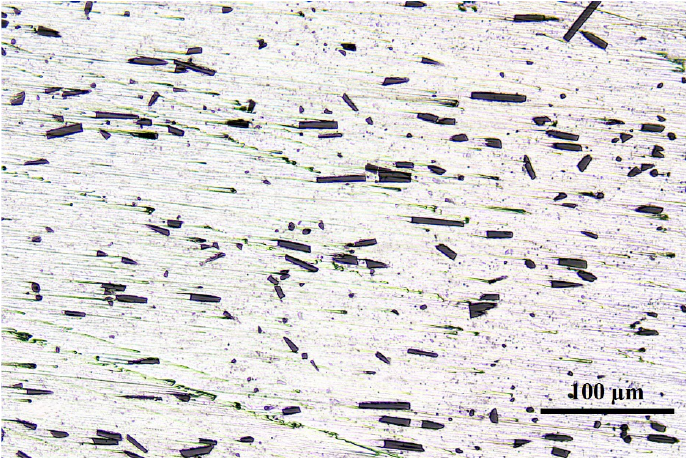
Figure 2. OM image of the surface along the extrusion direction of the sample.